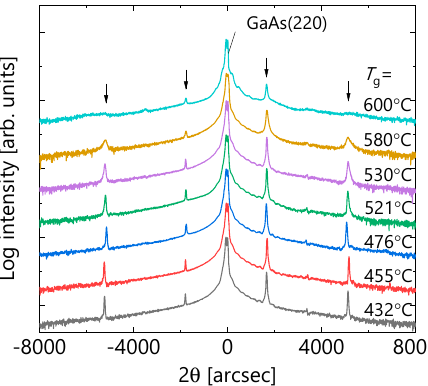
Figure 3. Atomic force microscopy (AFM) images with a scan size of 20 × 20 µm 2 in ( a , c , e , g , h ), and